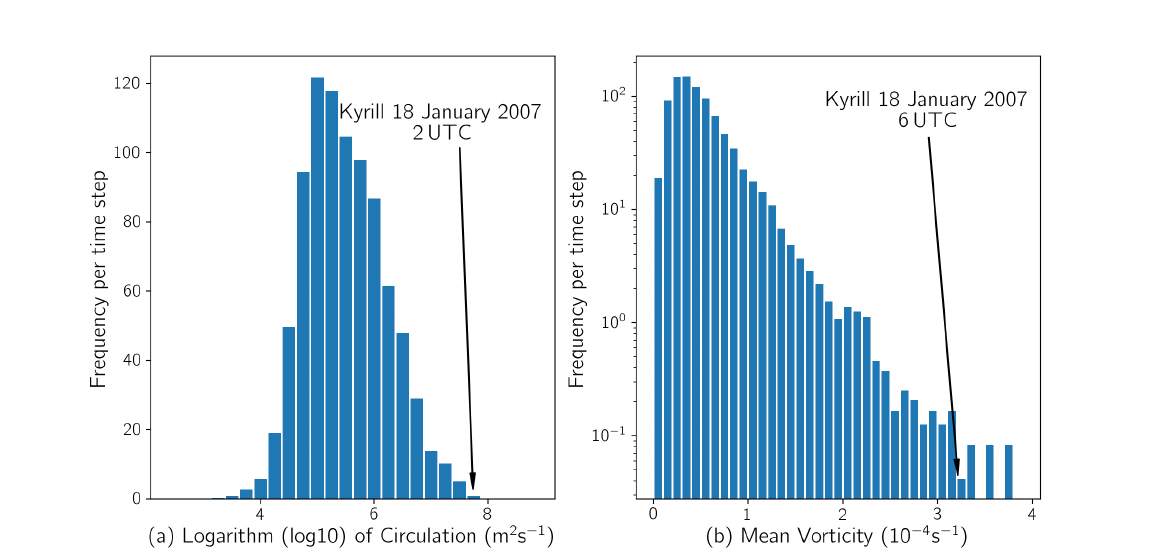
Figure 8. Frequency-intensity distributions of ( a ) the logarithm of the circulation magnitude (m 2 s − 1 ) and ( b ) mean vorticity ζ (10 − 4 s − 1 ) of vortices identified in CFSR data in the Northern Hemisphere ( ≥ 25 ◦ N) in the period between 17 January 2007 00UTC and 19 January 2007 12UTC (60 time steps). Frequencies are averaged over all time steps to derive a frequency per (one-hour) time step. Maximum values of Kyrill and their time of occurrence are indicated by the arrows and